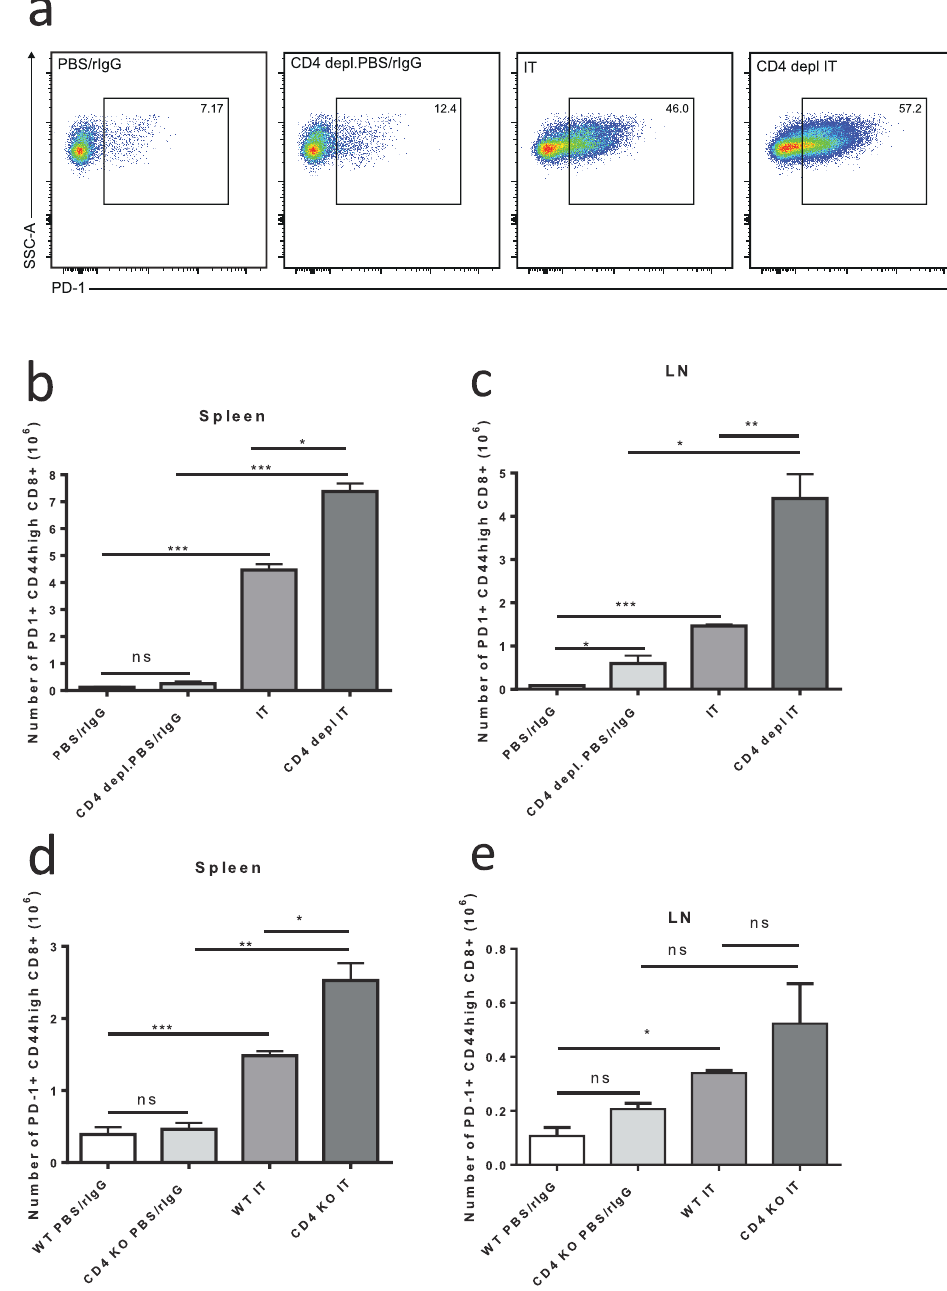
Figure 3. Increased number of PD-1 + memory CD8 + T cells after IT in CD4 + T cell deficient mice. Control or CD4 deficient (depleted or knockout) C57BL/6 mice were treated with IT or PBS/rIgG (control) and PD-1 expression on memory T-cells was quantified by flow cytometric analysis 11 days after the initiation of IT. ( a ) Representative dot plots for PD-1 + gating on CD8 + CD44 high cells in the spleens of CD4 + depletion model mice. Number of PD-1 + memory (CD44 high ) CD8 + T cells in spleens ( b,d ) and LNs + ( c,e ) of IT or vehicle treated mice in CD4 + depletion ( b,c ) or CD4 knockout ( d,e ) models. Results are representative of two (CD4 knockout) or three (CD4 depletion) independent experiments with a minimum of three mice per group. (* P , .05, ** P , .01, *** P , .001).